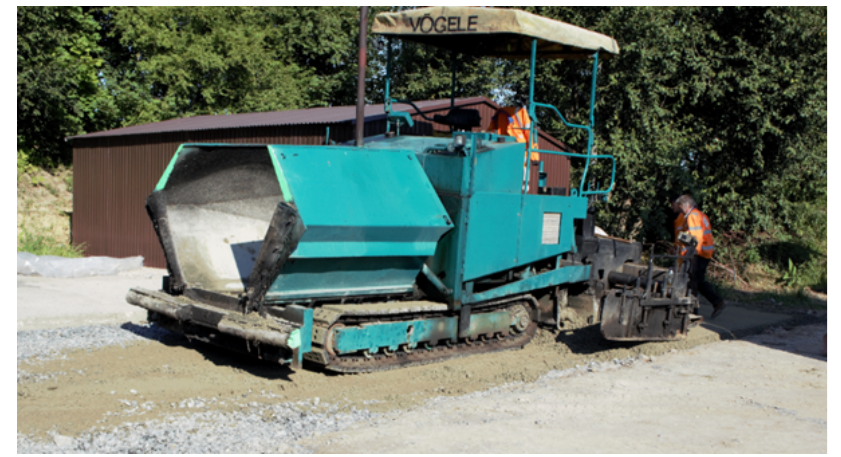
Figure 2. Finisher